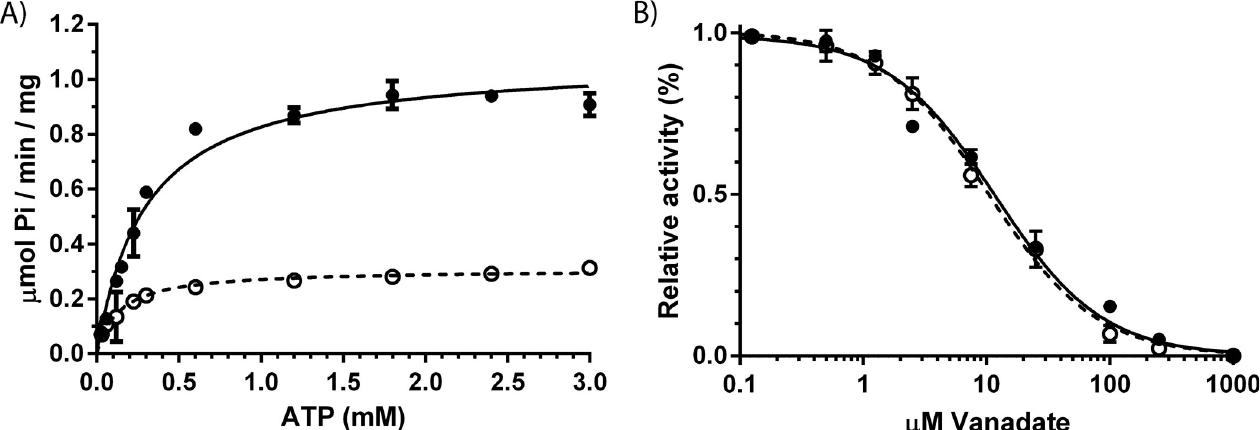
Fig 2. ATP affinity and vanadate sensitivity of purified Spf1p in mixed YPL/detergent micelles (0.35% w/w). A) ATP affinity of Spf1p in YPL/OG micelles (open circles, dotted line with K m = 0.1332 ± 0.0189 mM ATP and V max = 0.3065 ± 0.0969 μ mol Pi/min/mg) and in YPL/Tween20 micelles (black circles, black = 1.072 ± 0.0270 μ mol Pi/min/mg). Curve fittings was performed using Michaelies-Menten kinetics. B) line with K m = 0.2977 ± 0.02569 mM ATP and V max Vanadate sensitivity of Spf1p in mixed YPL/OG micelles (open circles, dotted line with K i = 10.30 ± 0.7471 μ M) and YPL/Tween20 (black circles, black line with K i = 10.30 ± 0.7471 μ M). Curve fittings was performed using Substrate inhibition kinetics. All experiments are performed as technical triplicates ( n = 3) and is reported as the average value of these with error bars indicating the standard error.